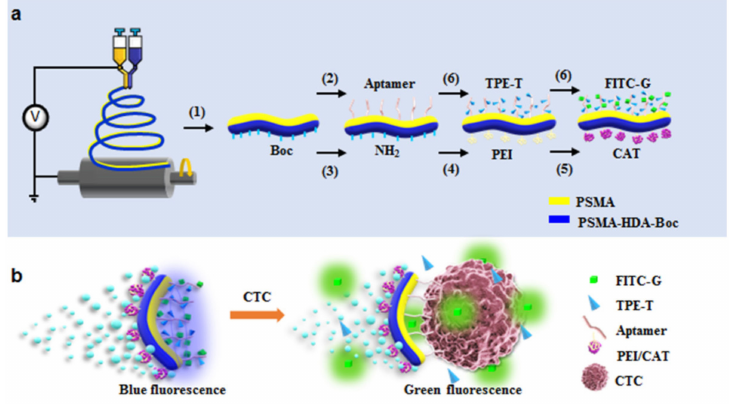
Figure 13. ( a ) Preparation of self-propelled JMs. ( b ) Ratiometric fluorescence response of JMs after the capture of CTCs. The binding between fluorophores with aptamers on JMs resulted in the ACQ effect of FITC-G and AIE of TPE-T, leading to blue fluorescence emission. In the presence of CTCs, the fluorescence of TPE-T was weakened rapidly, and that of FITC-G was restored to emit green fluorescence. Reprinted with permission from ref. [120]. Copyright © 2019 Elsevier B.V.